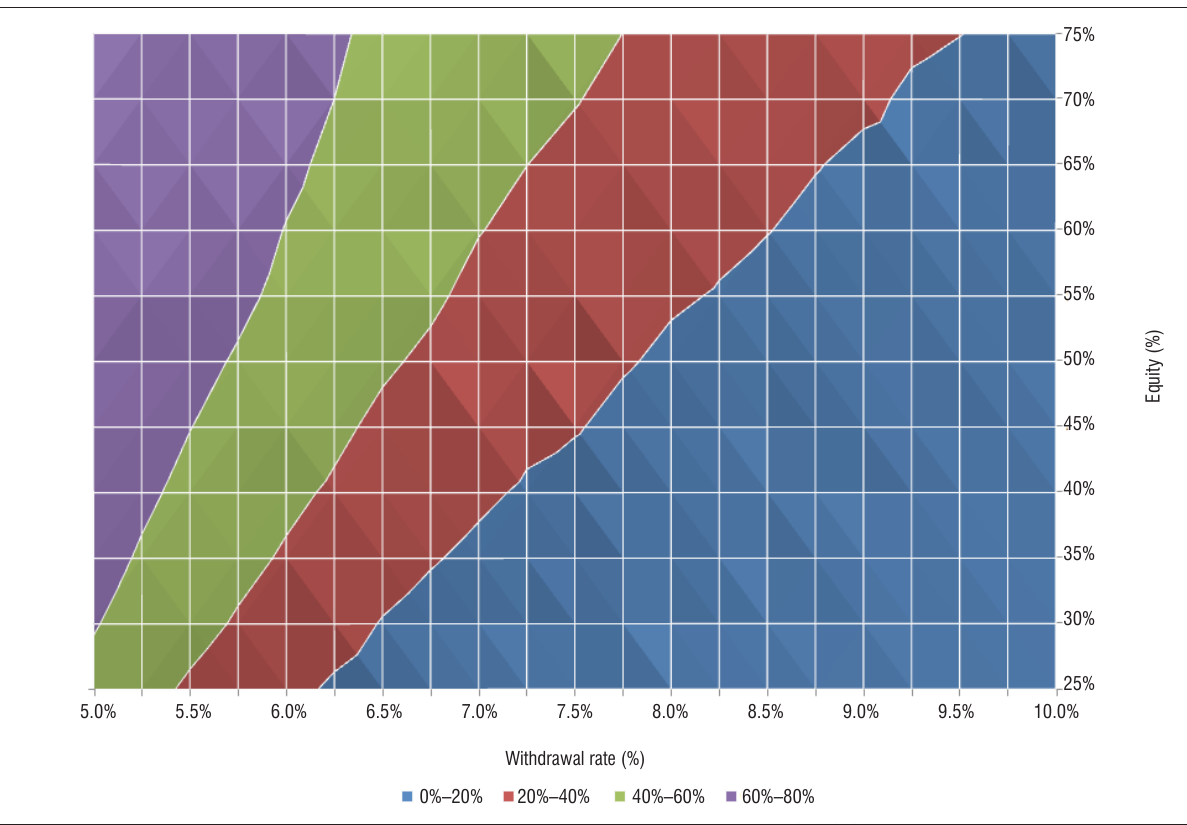
Figure 3: Portfolio success rate as a function of the withdrawal rate and equity